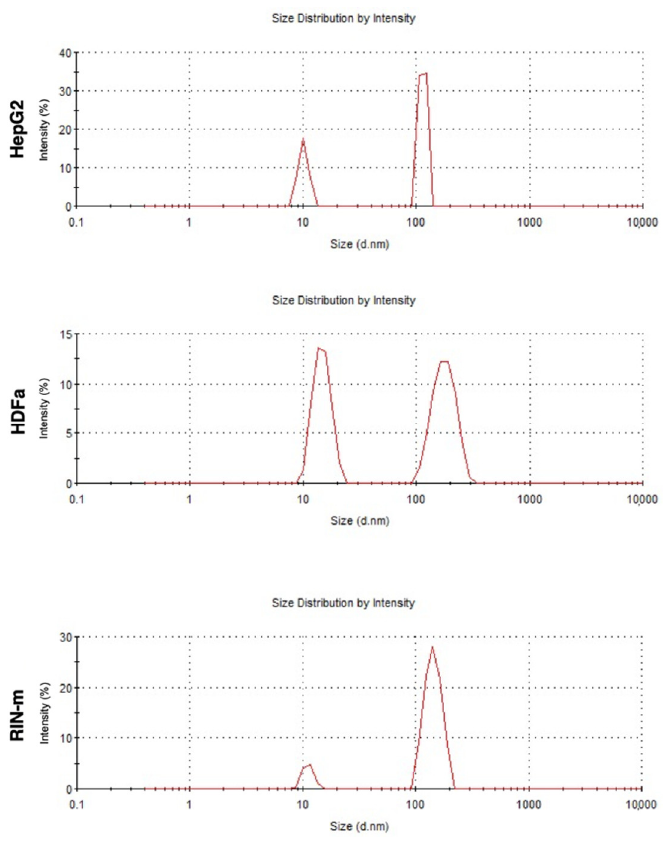
Figure 1. DLS size characterization for HepG2-, HDFa- and RIN-m- derived exosomes.